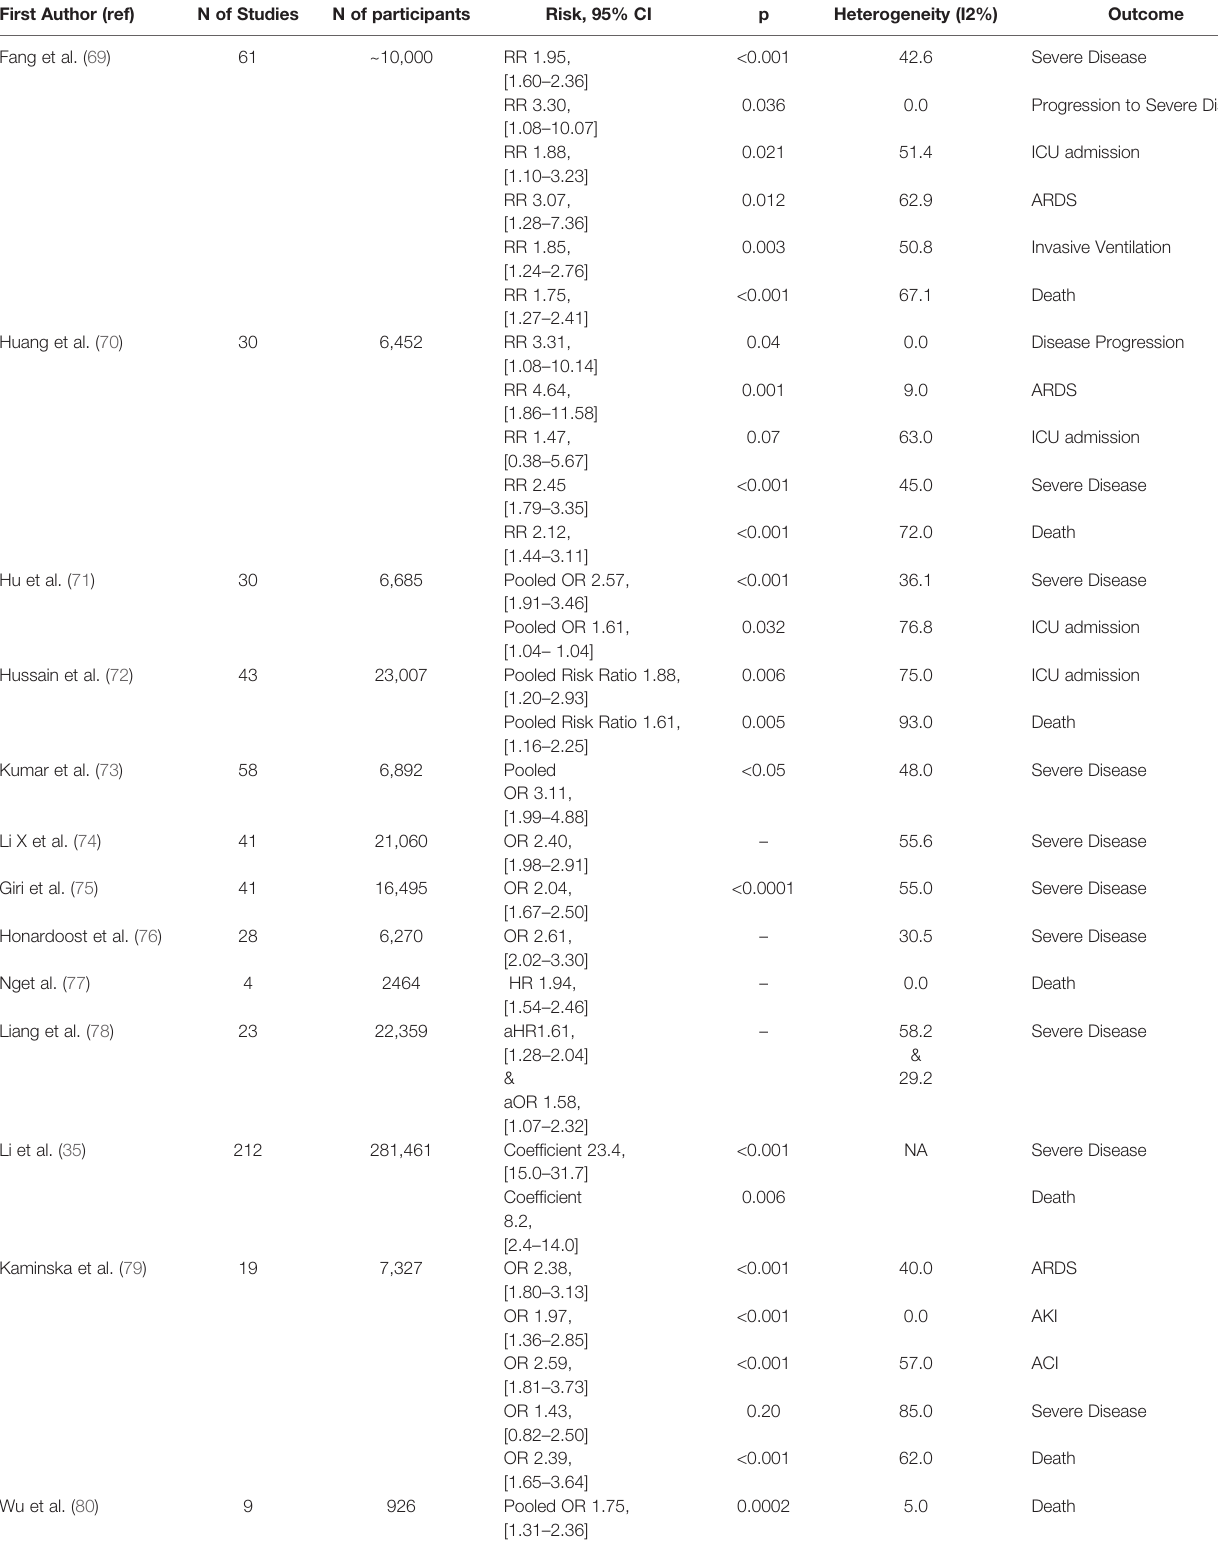
TABLE 2 | Meta-analyses that highlight diabetes mellitus as a risk factor for mortality and/or complications from COVID-19